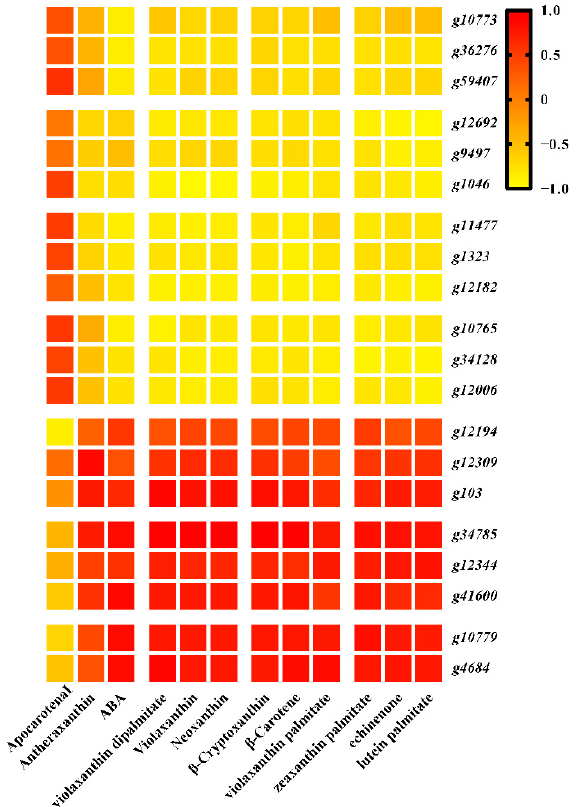
Figure 7. Correlation between DEGs and DAMs trends, with stronger correlations corresponding to a more consistent trend.